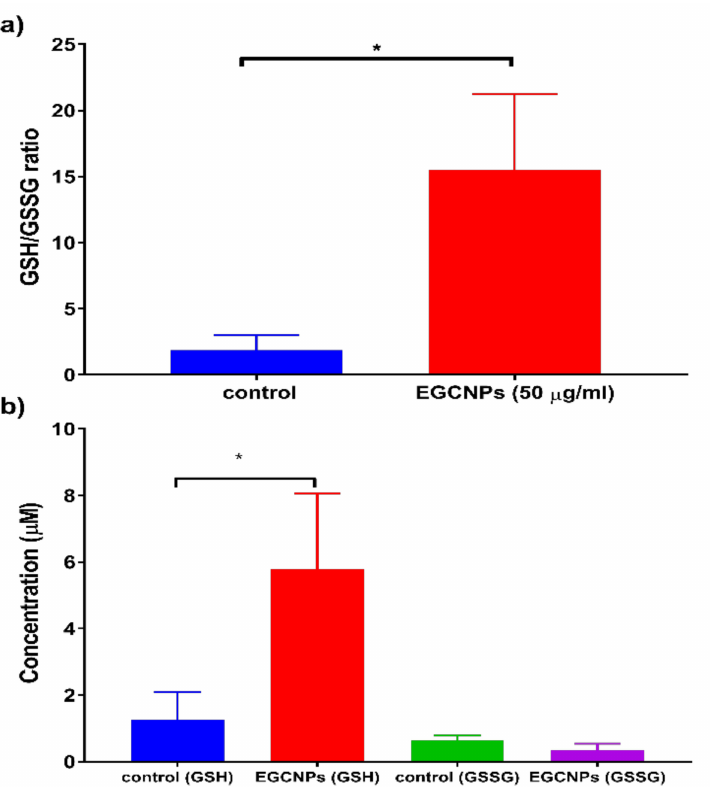
Figure 4. Effect of EGCNPs on GSH/GSSG ratio in HLECs: ( a ) The 48 h exposure to EGCNPs (50 µ g/mL) significantly increase GSH/GSSG ratio compared to negative control and ( b ) the effect of EGCNPs (50 µ g/mL) on GSH and GSSG concentrations in HLECs after 48 h exposure. The asterisk denotes statistical significance ( n = 5, p < 0.05, Student’s t-test). Error bars are presented as means ±